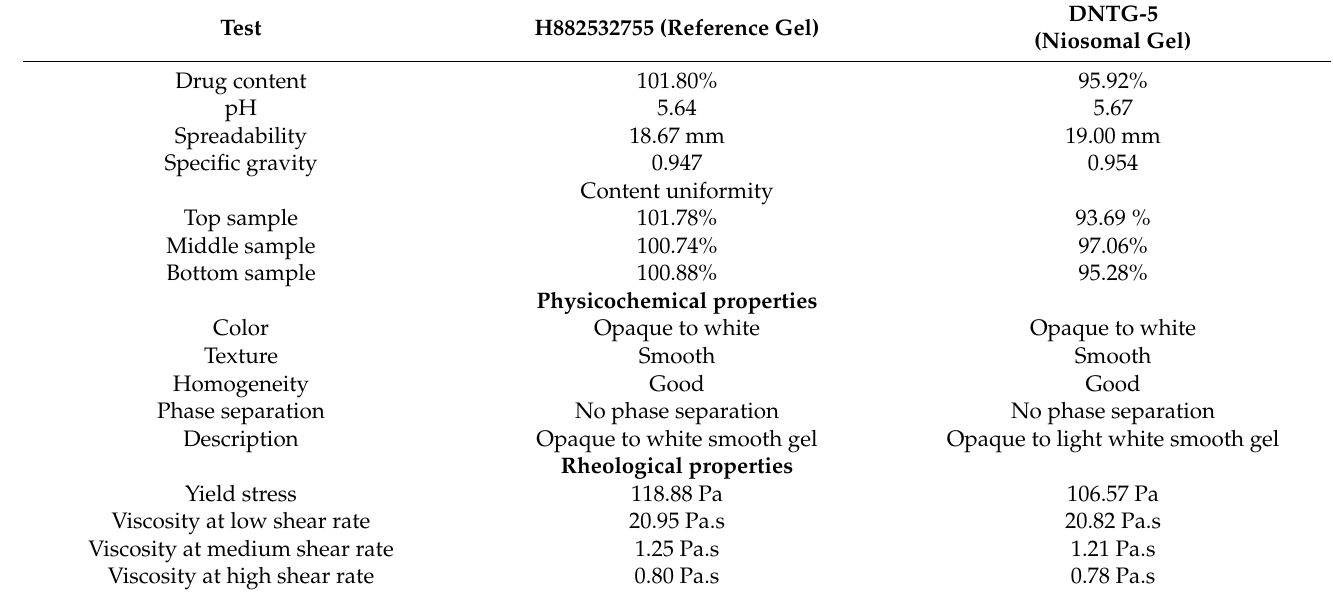
Table 8. Data comparison of desoximetasone niosomal gel and reference